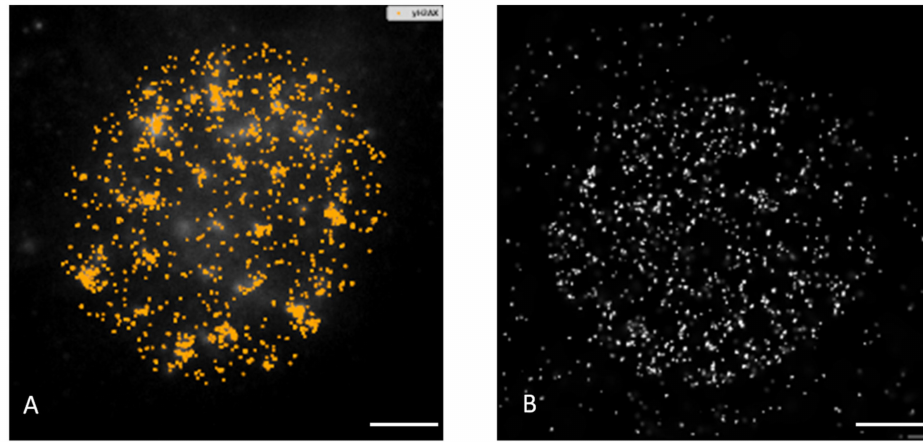
Figure 9. Typical examples of artificial images obtained from data of the “orte matrix”. ( A ) γ H2AX signals ( orange ) 30 min after incubation of SkBr3 cells with GNPs and 2 Gy radiation exposure. This image is merged with the real widefield DAPI image ( shadowed ). ( B ) H3K9me3 heterochromatin signals without DAPI image of the cell nucleus of a non-irradiated control with GNPs. Scale bar 2 µ